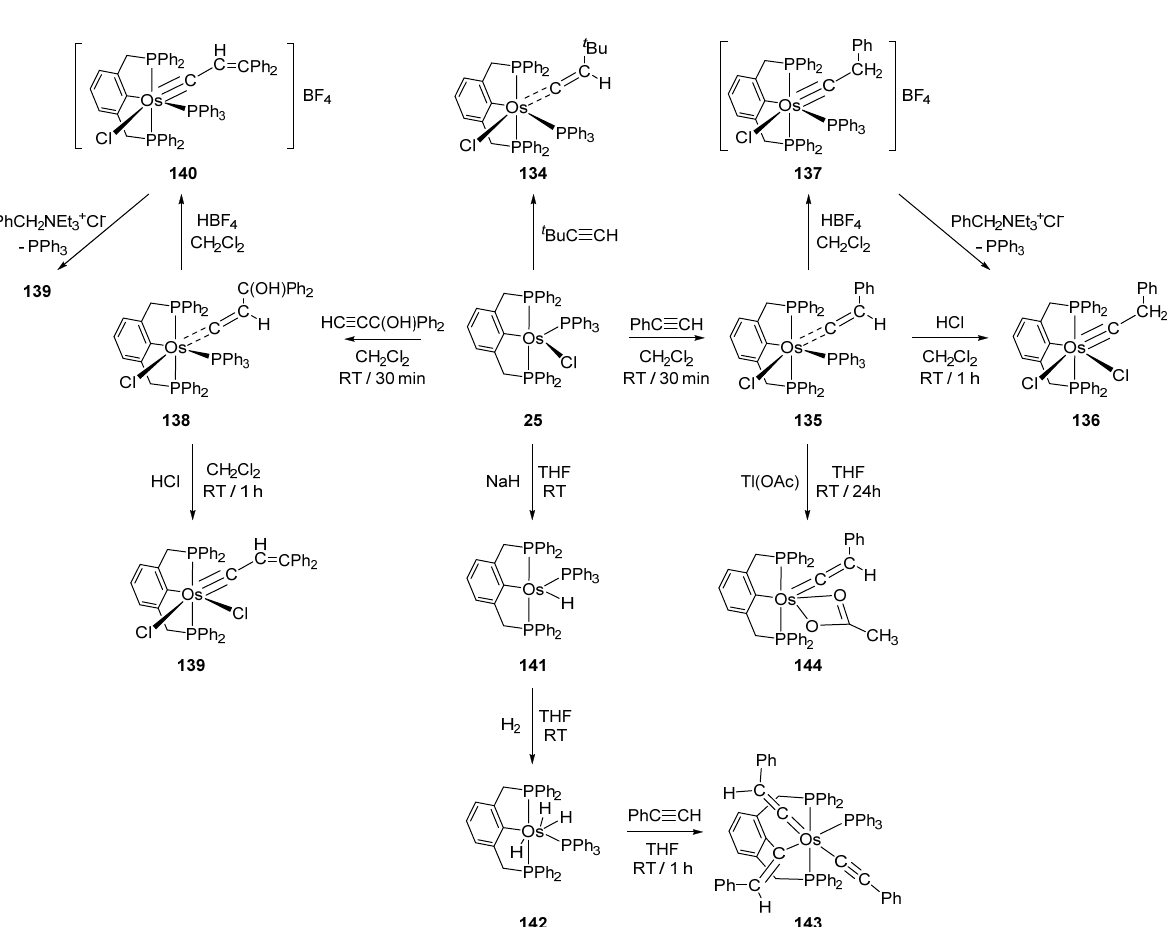
Figure 29. Reactivity of P~C~P pincer complexes 108 and 109 .